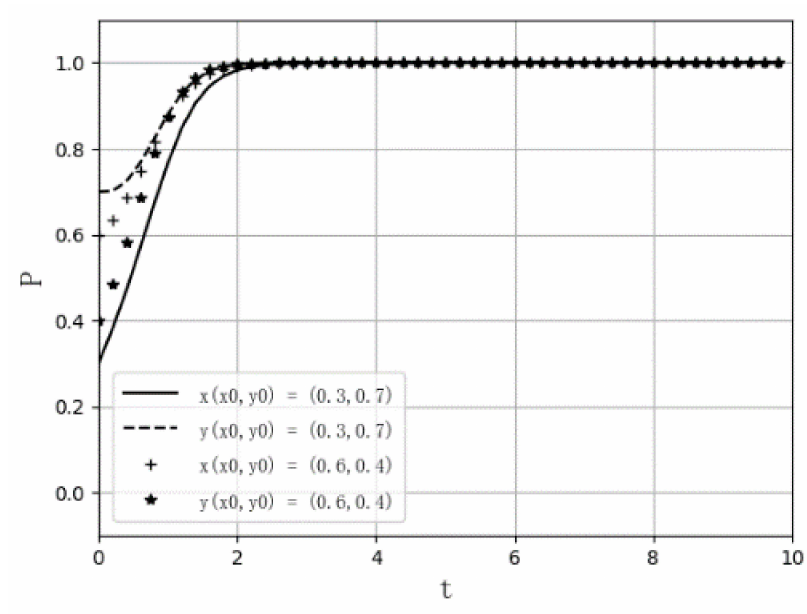
Figure 10. Path diagram of the evolutionary game of Scenario 3 (I 2 + B < I 3 + R 2 − F, G 1 − G 2 > A and I 1 − R 1 − ( I 2 − R 2 ) + I 2 + B − ( I 3 − F + R 2 ) > 0). (4) Scenario 4: I 2 + B < I 3 + R 2 − F and G 1 − G 2 < A. Set the parameter values as: I 1 = 9, I 2 = 7, I 3 = 10, G 1 = 15, G 2 = 10, R 1 = 5, R 2 = 4, F = 5, B = 3, A = 6, and set